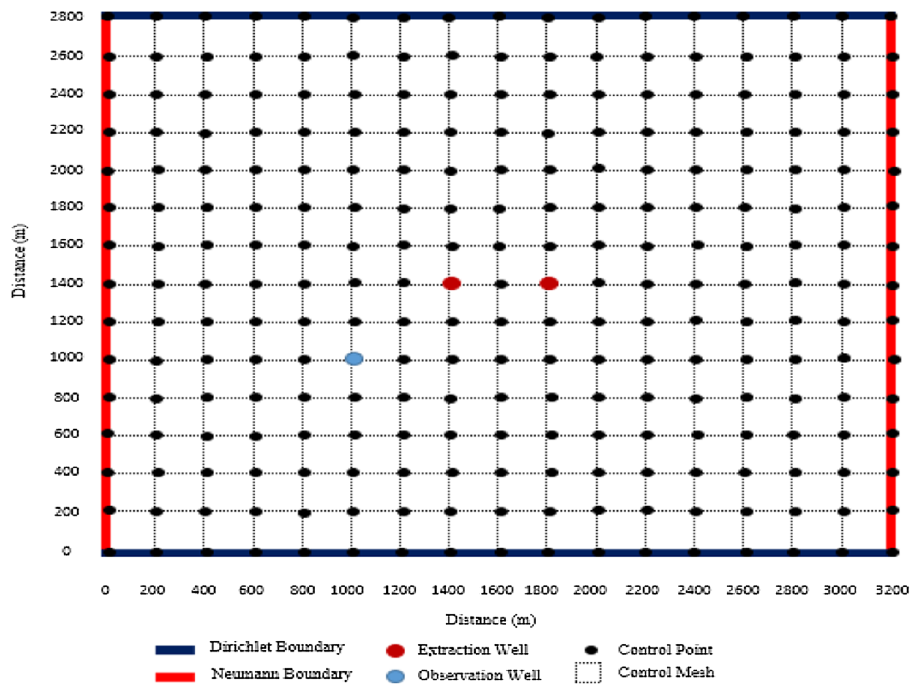
Fig. 1 Location of extraction wells and observation well on the control points. In an uncon- fined